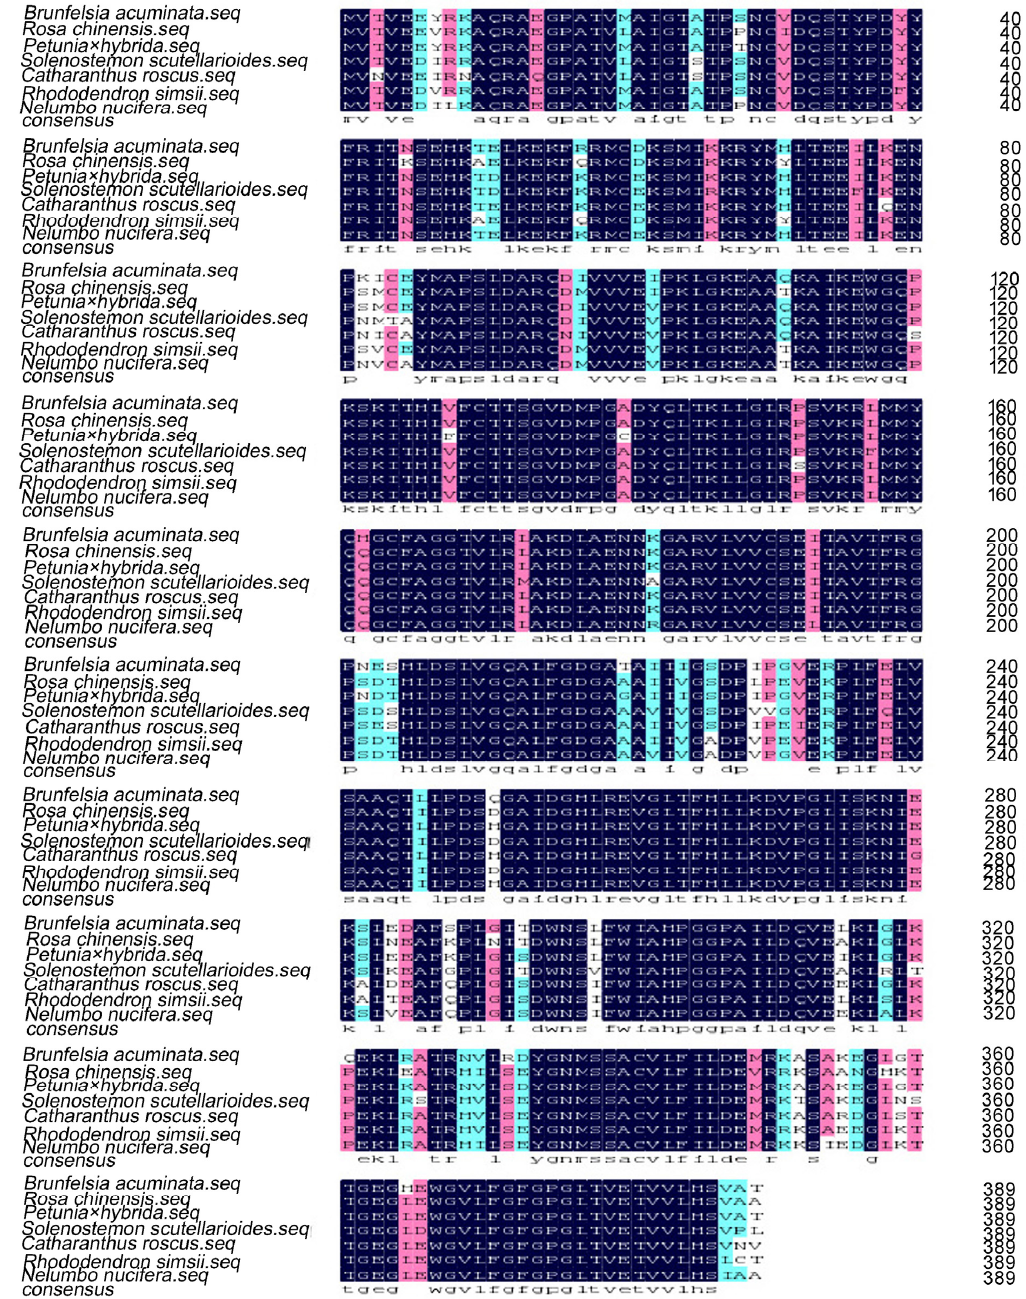
Figure 4. Multiple alignment of predicted amino acid sequences of CHS from different plants. Petunia hybrida , CAA32731.1; Rosa chinensis , AEC13058.1; Solenostemon scutellarioides , ABP57071.1; Catharanthus roseus , CAA10511.1; Rhododendron simsii , CAC88858.1; Nelumbo nucifera ,